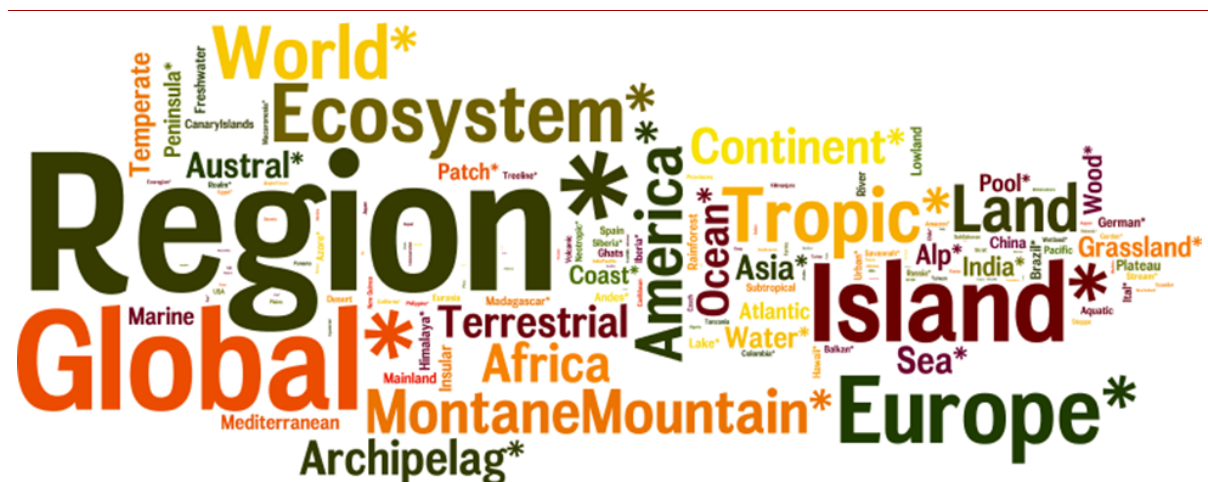
Figure 2. Terms related to place that appeared commonly in abstracts submitted for the 7 th IBS biennial meeting. Analysis as described in the caption to Figure 1; based on n = 1793. Asterisks indicate the word also occurred in plu- w ral or other form (e.g., “America*” represents “North …”, “Central …”, and “South America” as well as the “Americas”; “Ocean*” includes all and any oceans; and so on). The most common term (“Region*”) in the analysis occurred in 144 abstracts; the least common term in the analysis occurred once. “MontaneMountain*” represents occurrences of “montane” or “mountain*” which were often used synonymously but are not captured by a single meaningful string of